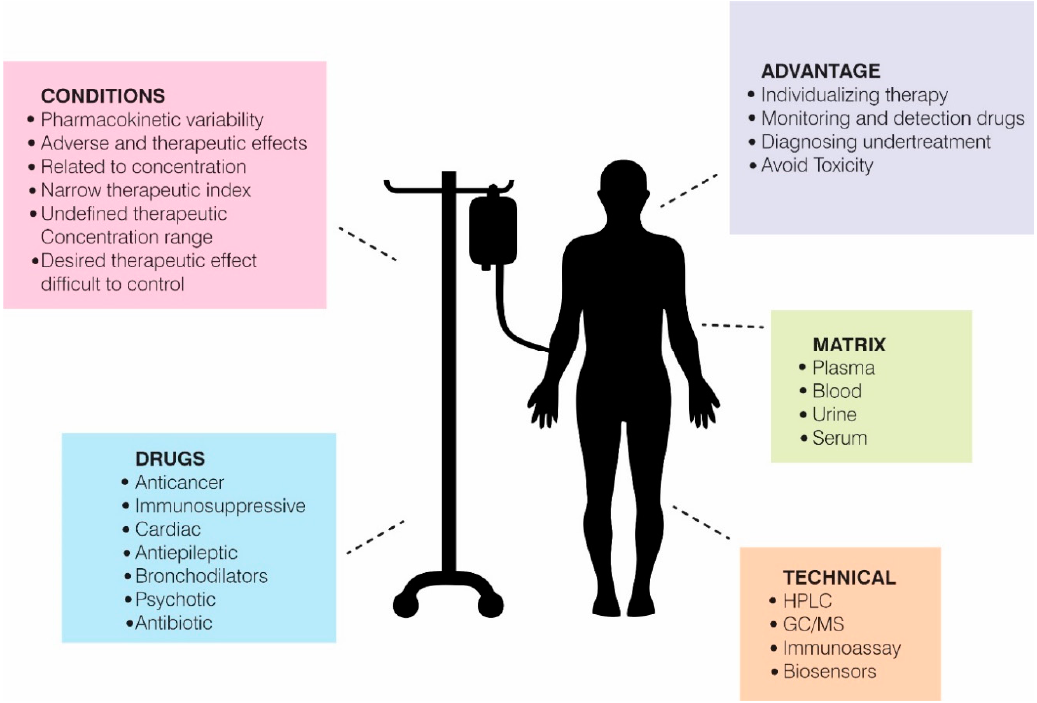
Figure 1. Therapeutic drug monitoring (TDM). TDM is a fundamental tool for the management of drugs with a narrow therapeutic window and high toxicity. For this, different conditions have been established that limit a drug to belong to this group of molecules. These molecules are quantified by different methods, such as HPLC, GC/MS, immunoassays, and biosensors using different body fluids (matrix), with advantages for public and patient health.